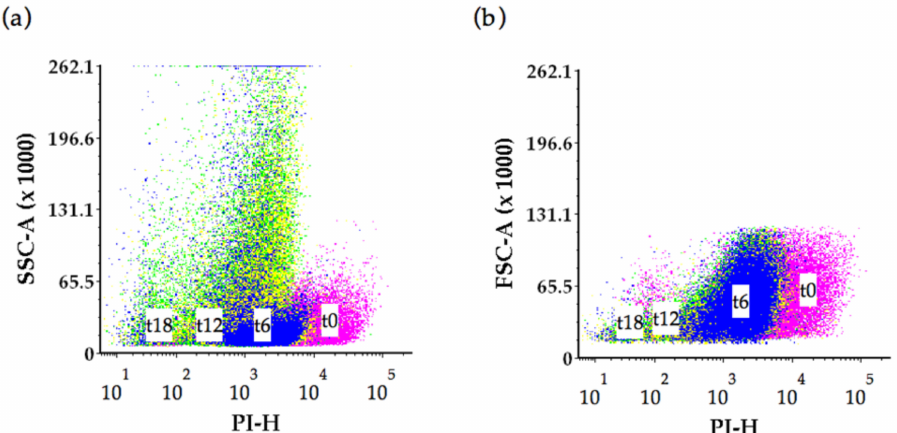
Figure 7. Flow cytometry ( a ) side scatter (SSC-A) parameter and ( b ) forward scatter (FSC-A) parameter, for S. cerevisiae cells from the control tracked over 0-, 6-, 12-, and 18-months wine ageing. Dots represent yeast replicates at 0 months (magenta); 6 month old lees (blue), 12 month old lees (yellow) and 18 month old lees